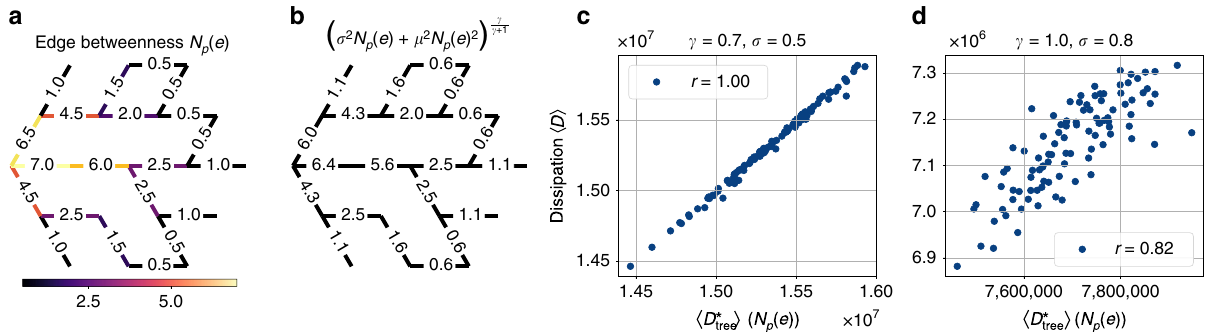
Fig. 6 Edge betweenness centrality determines the network dissipation at local minima in the fl uctuating sink model. a Edge betweenness centrality N p ( e ) (numbers and colour code), determined with respect to a single source on the left, is closely related to the network dissipation. b The contribution (cid:11) (cid:12) γ i as given in Eq. (31) may be used to estimate the γ þ 1 of a single edge to the minimal network dissipation in a tree network h D (cid:4) N p ð e Þ (cid:3) σ 2 þ N p ð e Þ 2 (cid:3) μ 2 tree i correlates strongly with the actual network dissipation at minima. Parameters used here are given by σ = 0.5, μ = 1 and γ = 0.9. c The tree estimate h D (cid:4) tree actual network dissipation at local minima 〈 D 〉 with high-cost γ = 0.7 and low fl uctuations σ = 0.5 since on average only 〈 N L 〉 = 1.44 loops form for this set of parameters (Pearson correlation coef fi cient of r = 1.0). d Moving to networks containing many loops, 〈 N L 〉 = 36.66 on average, obtained by minimising the dissipation for lower cost γ = 0.8 and more fl uctuations σ = 1.0, the tree estimate still strongly correlates with the dissipation at minima as measured by a Pearson correlation coef fi cient of r = 0.82. Results were obtained by applying the relaxation method 100 times for each set of parameters where the set of potential edges E forms a triangular network with N = 169 nodes as shown in Fig.